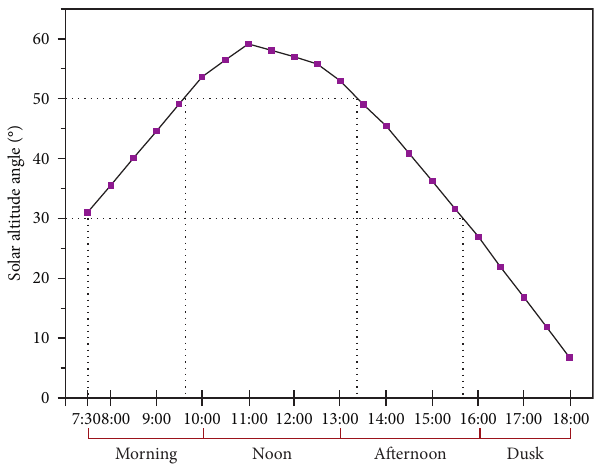
Figure 11: Time division of the measurement